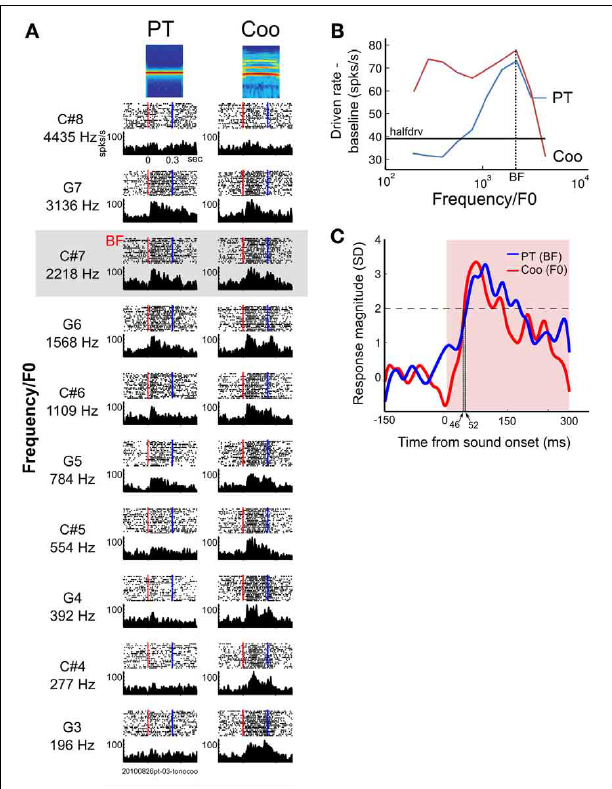
FIGURE 6 | Example of a neuron in A1 showing frequency-representative responses to pure tones and pitch-shifted coos. (A) Spike rasters (upper half of each graph) and PSTHs (lower half) aligned to sound onset (red dotted line) in response to pure tones (left column) and pitch-shifted coos (right column) at the same pitch (196–4435Hz at half-octave steps). The blue line marks sound offset. (B) Tuning curves for Unit A, shown in (A) . The tuning curves resulting from peak responses to PTs and to the pitch-shifted coo, which is based on the fundamental frequency (F0) of the coos. Black horizontal line indicates half-driven rate. This type of neuron continued to show high firing rates when the overtone harmonics of the pitch-shifted coo fell into the neuron’s RF, even when the F0 of the coo was outside the RF. (C) Averaged PSTH of the responses of Unit A to its BF (solid blue line) and to a coo (solid red line) whose F0 was matched to the BF. The latency in response to the BF-PT was 46ms, whereas the latency in response to the coo was 52ms. Sound duration period is shown in pink; sound onset is indicated by the vertical edge at time zero.